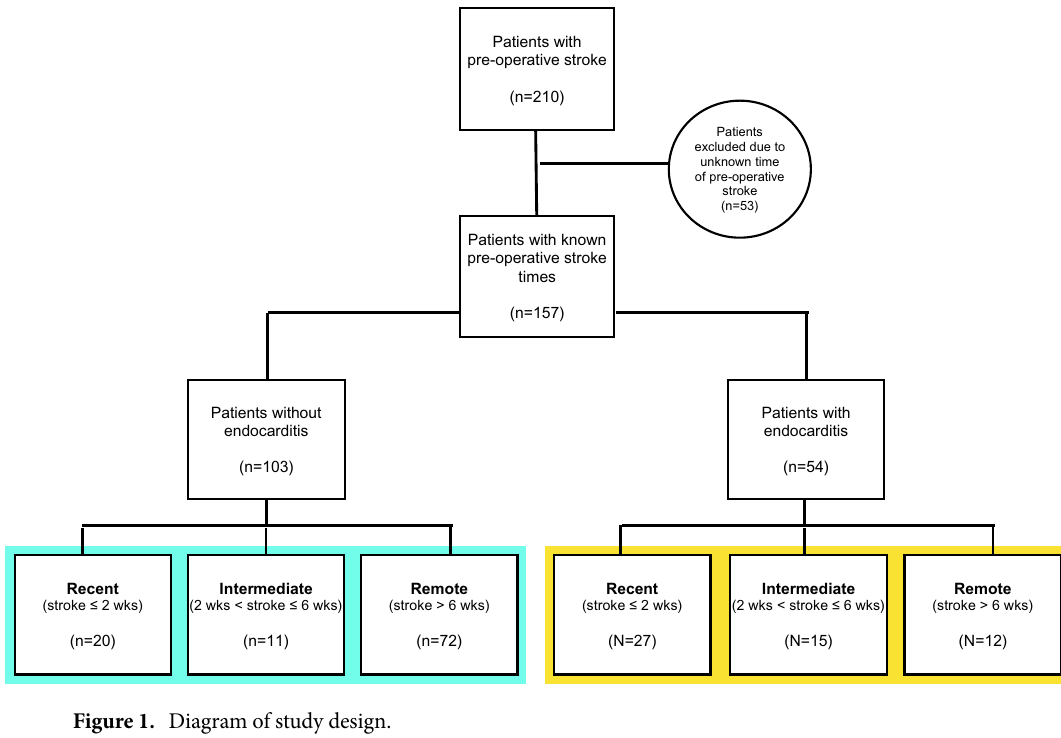
Figure 1. Diagram of study